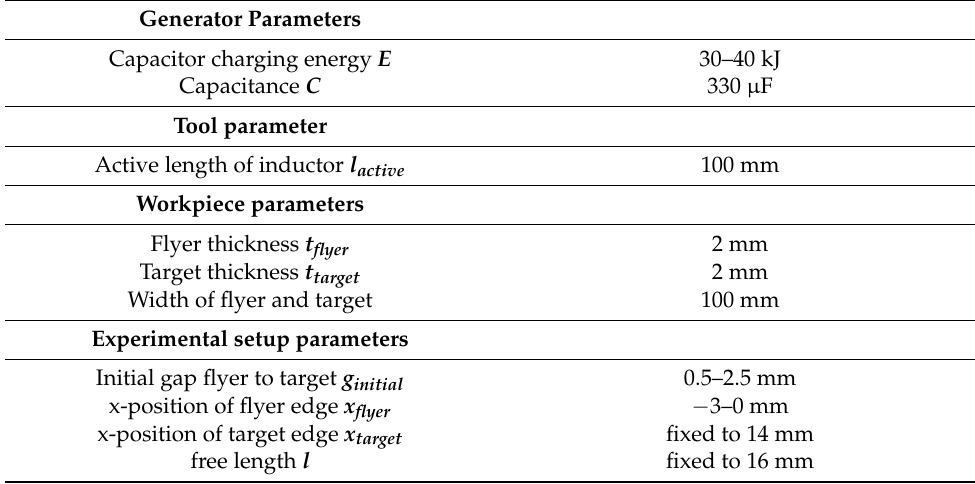
Figure 2. ( a ) Scheme of experimental setup; ( b ) Process states during the welding step; ( c ) Real MPW setup with the used trident-shaped coil and the pulsed power generator. Table 2. Parameters of the experimental MPW process.